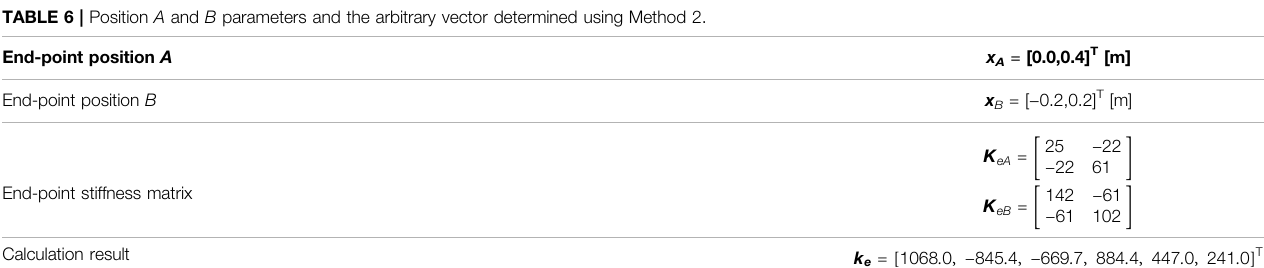
TABLE 6 | Position A and B parameters and the arbitrary vector determined using Method